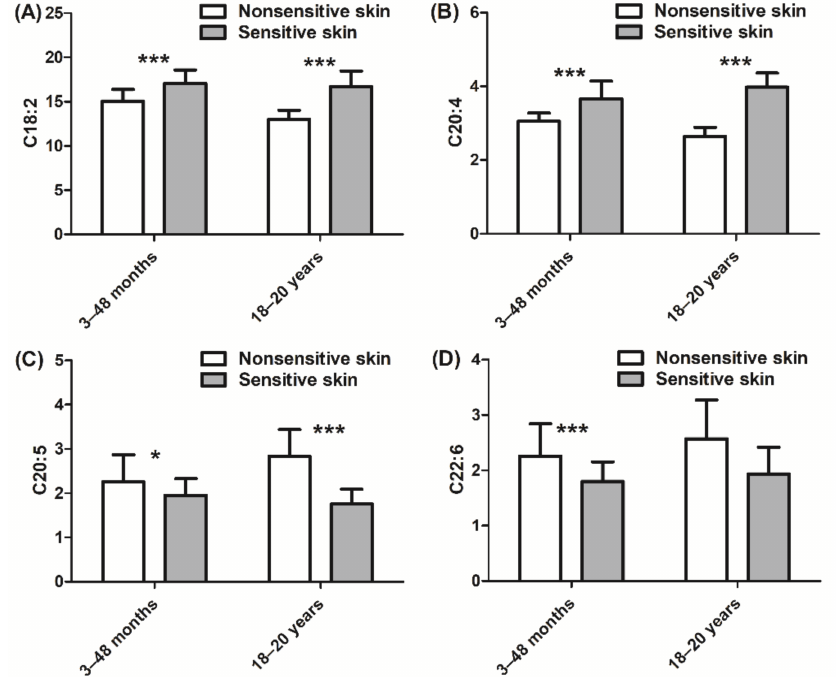
Figure 5. Quantification of PUFAs (polyunsaturated fatty acids): ( A ) C18:2 linoleic acid; ( B ) C20:4 arachidonic acid; ( C ) C20:5 eicosapentaenoic acid; ( D ) C22:6 docosahexaenoic acid. Data are shown as the mean ± SD of all subjects in the group. * p < 0.05, *** p <